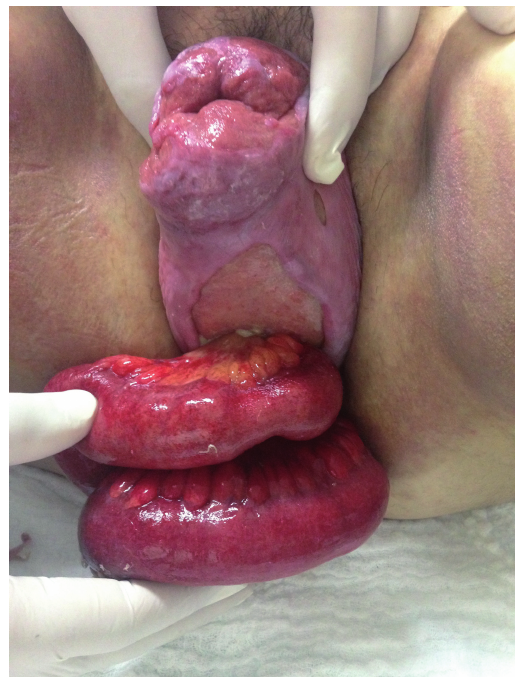
figure 1 - preoperative.